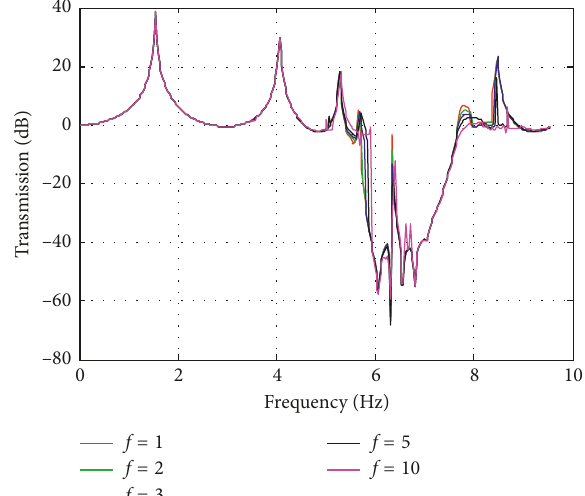
Figure 16: External excitation amplitude has changed the bandgap width.